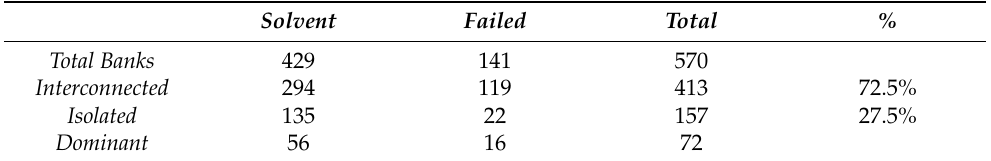
Table 3. Composition of the 570 banks network using both the Tier 1/total asset and the total interest expense/total interest income. Threshold level = 0.8. Solvent